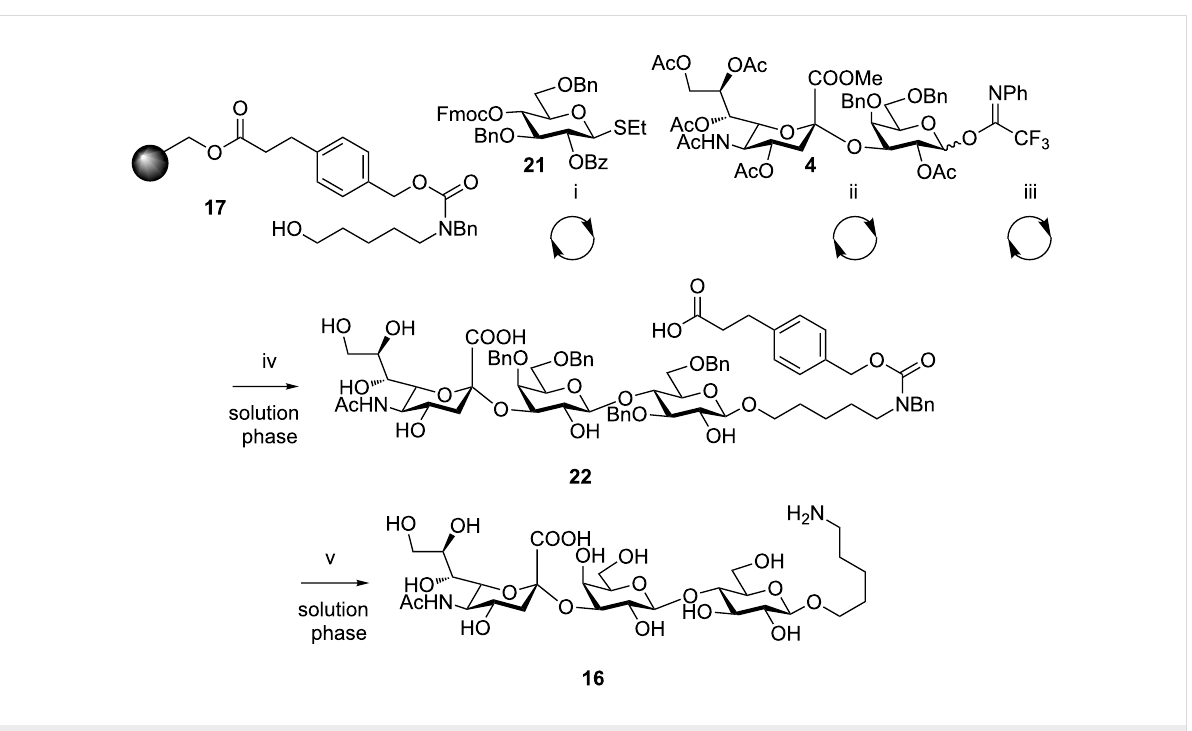
Scheme 4: Automated synthesis of 16 . Reagents and conditions: (i) (a) NIS, TfOH, dioxane, DCM, − 40 to − 20 °C, 40 min; (b) piperidine, DMF. (ii) (a) TMSOTf, DCM, 0 °C, 2 h; (b) piperidine, DMF. (iii) NaOMe, MeOH, DCM, 1.5 h. (iv) KOH, MeOH, H 2 O, THF, 60 °C, 40%. (v) Pd/C, H 2 , MeOH/H 2 O, cat. AcOH, 91% (for experimental details see the supporting information of